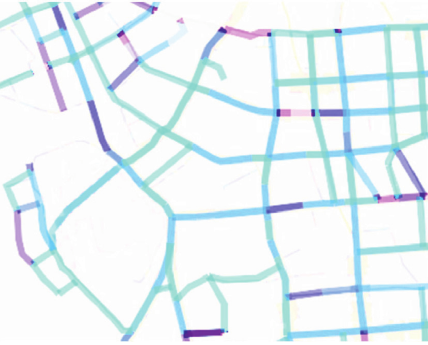
Figure 3: Vehicle track distribution diagram.